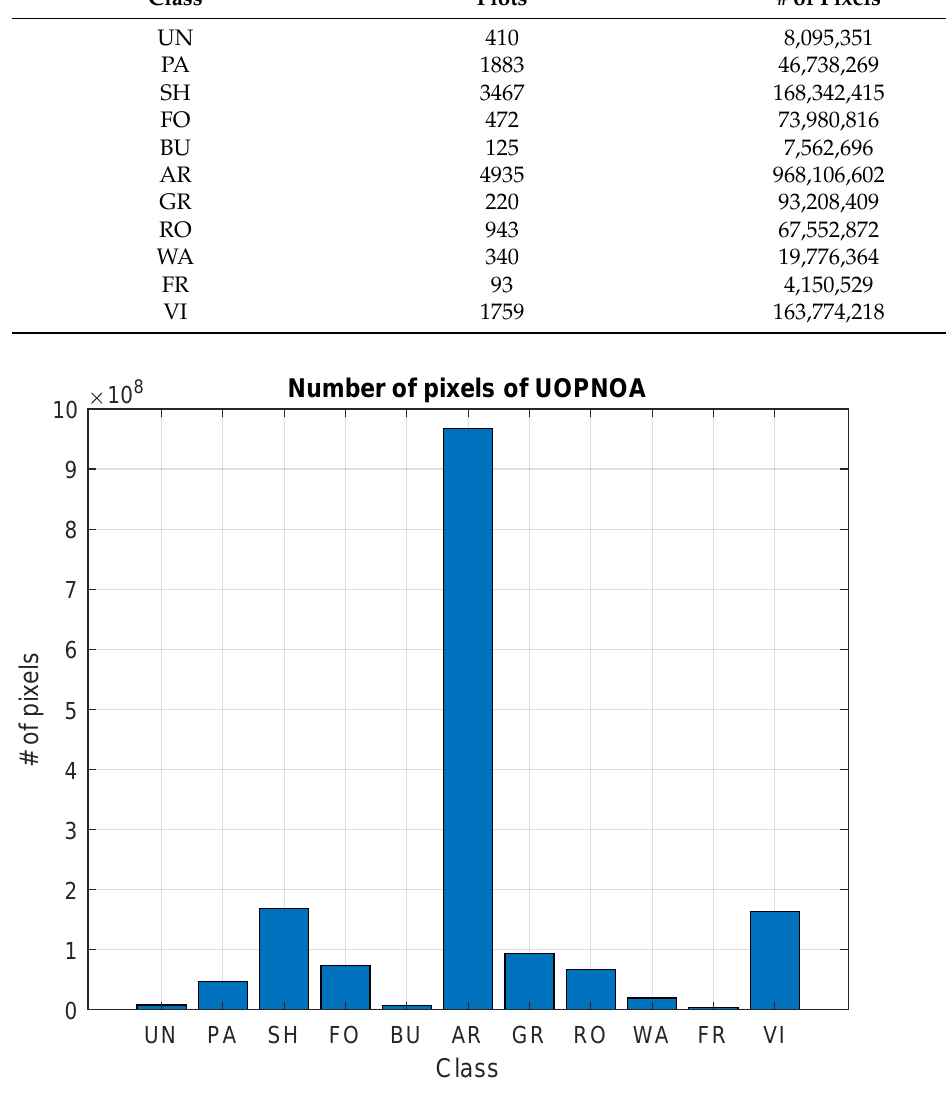
Figure 2. Number of pixels for each class of the dataset